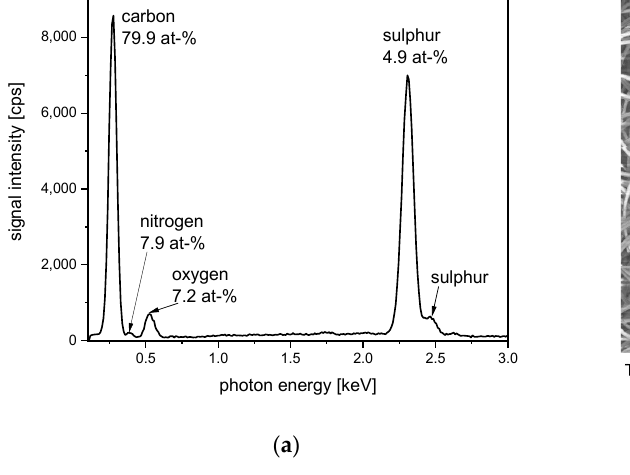
Figure 14. Non-woven filter material made from PPS fibers and meta-aramid fibers—( a ) EDS spec- trum; ( b ) SEM image.